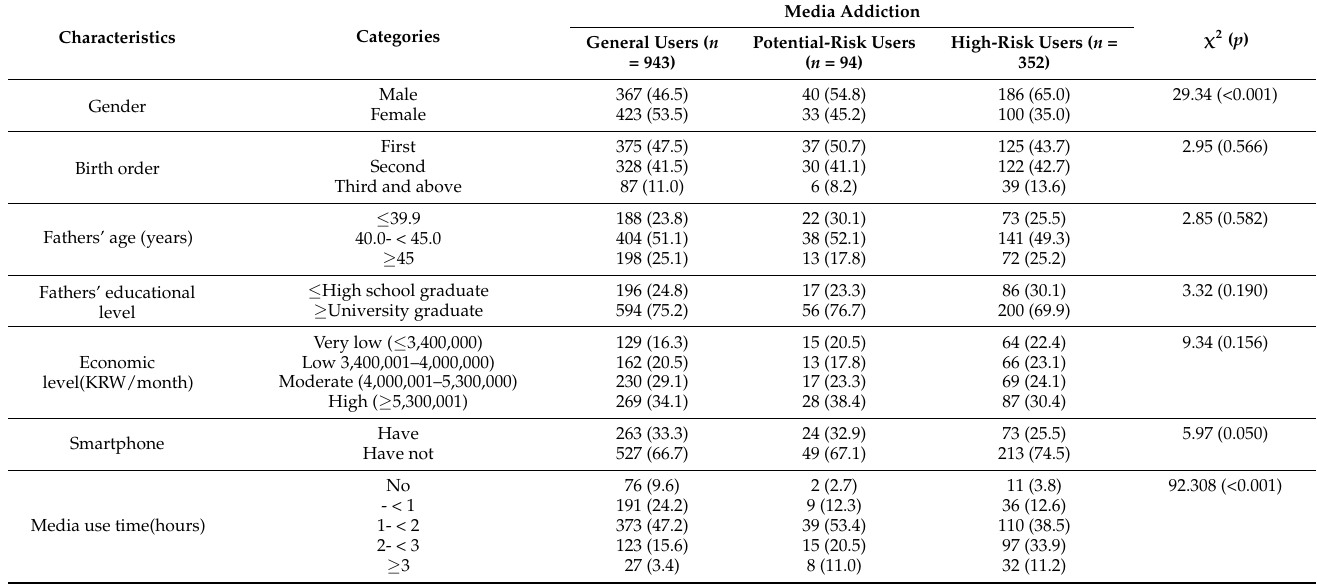
Table 3. Differences in media device addiction based on participants’ characteristics (N =